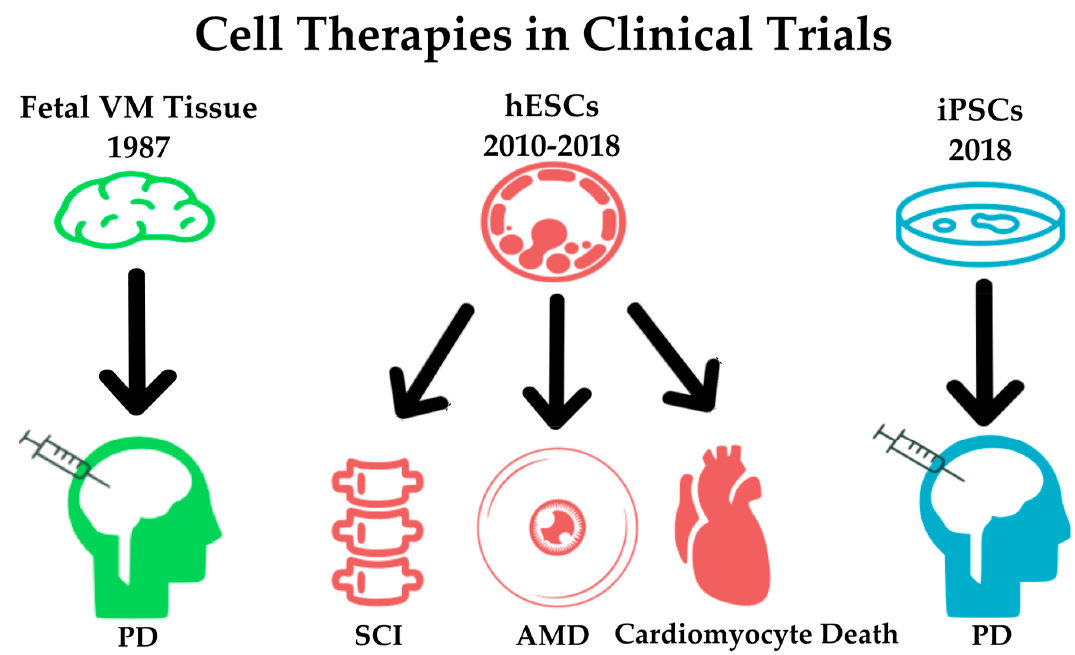
Figure 2. The progression of pluripotent cell-based therapies within the context of Parkinson’s Disease (PD) research. Beginning in 1987, fetal ventral midbrain (VM) tissue used as the cell source for the first clinical trial using cells to treat PD. In recent years, human embryonic stem cells (hESCs) are being utilized in a number of clinical trials involving neurodegeneration. Use of hESCs has shown special promise in spinal cord injury (SCI), age-related macular degeneration (AMD) as well as cell damage to the heart. In the summer of 2018, clinicians are beginning to undertake the first human trial using induced pluripotent stem cells (iPSCs) as a cell source to treat PD [57]. This trial will follow seven patients over the course of two years. The outcomes of these trials are detailed in the text.